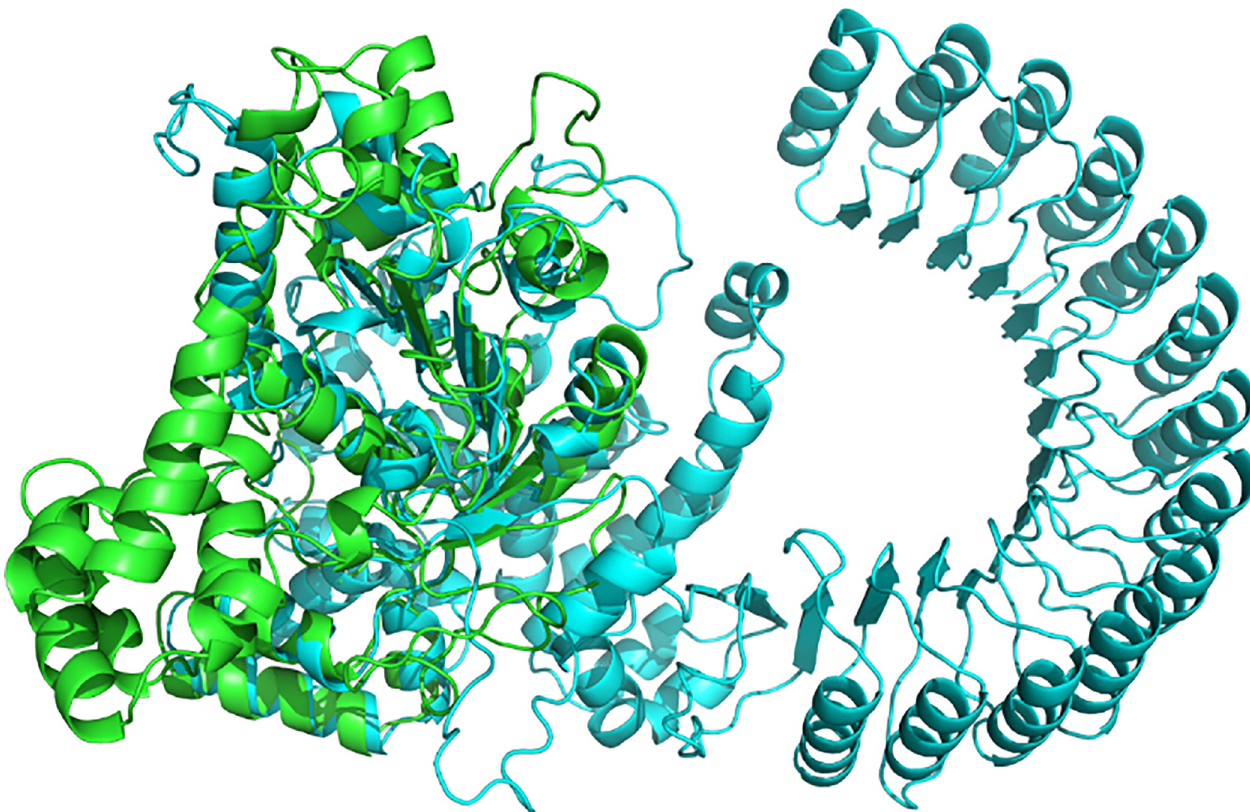
Fig 3. Structural Difference between Wild-type and C-terminal Truncated NLRP12 Proteins. Function predictions of the truncated protein and the wild-type (full-length) NLRP12 were carried out. The truncated protein (p.Trp408X) is represented in green. The full length protein is represented in blue. It is clear that the mutation disrupts the integrity of the NLRP12 protein.